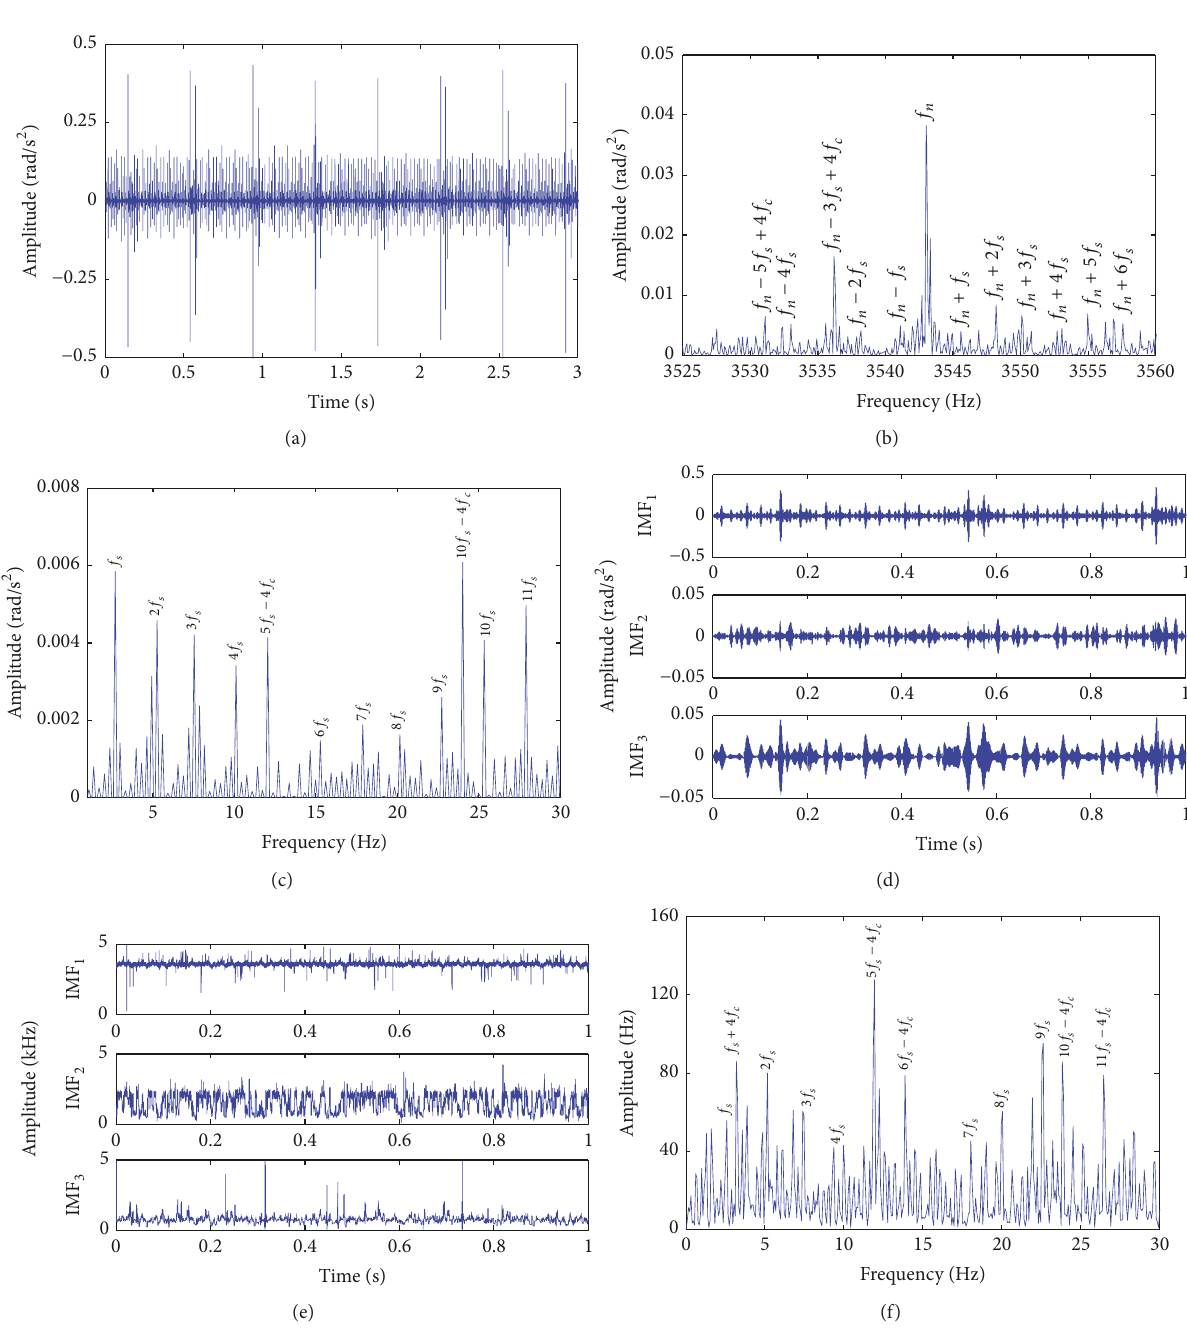
IMF1 has an instantaneous frequency fluctuating around the resonance frequency 𝑓 𝑛 = 3542.7 Hz and hence is selected for frequency demodulation analysis. Figure 5(f) shows the Fourier spectrum of IMF1 instantaneous frequency. Although the sun gear fault frequency harmonics plus or minus four times the planet carrier rotating frequency 𝑘𝑓 𝑠 ± 4𝑓 𝑐